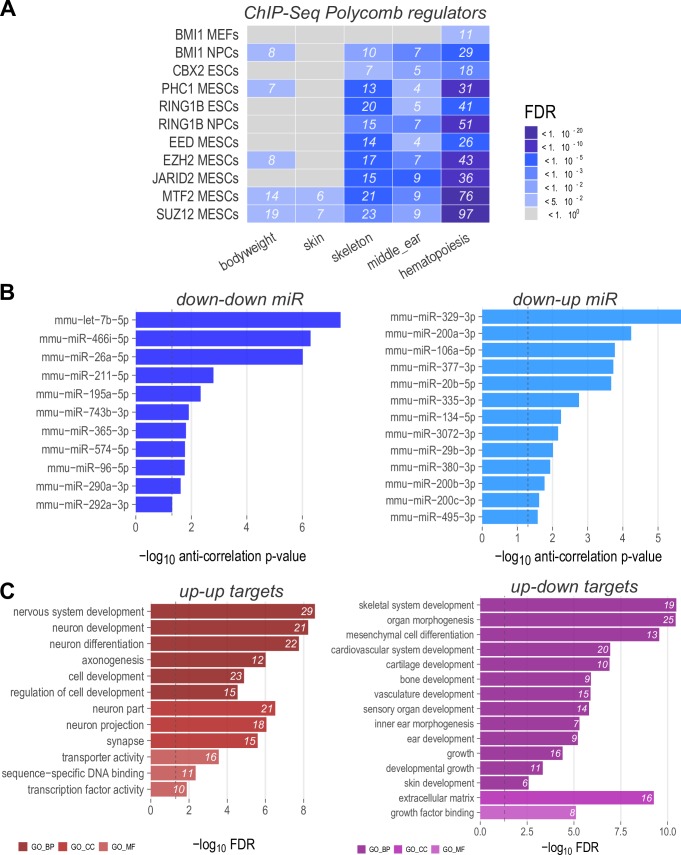
Regulatory network analysis highlights Polycomb group protein and miRNAs as possible regulators.A) Enrichment analysis of genes whose expression is changed by Hdhex4/5/ex4/5 null, that are involved in developmental phenotypes and regulated by Polycomb group proteins, based on ChEA ChIP-Seq annotation. Significance of enrichment is based on FDR values [color code as in the legend]. B) List of 22 miRNAs whose expression is altered by RA-differentiation and by Hdhex4/5 null genotype, but whose change in expression is significantly anti-correlated relative to expression change observed in the miRNA target genes. miRNAs identified by these criteria are by definition either down-down or down-up. miRNAs are ranked according to the p-value associated with the anti-correlation of their targets. C) Functional enrichment analysis of mRNA regulated by the 22 miRNAs displayed in Panel B. Only mRNAs affected by RA-Diff and the Htt null mutation, as well as anti-correlated with respect to their miRNA regulators were selected for the analysis. Enrichment FDR values are displayed in the bar chart.